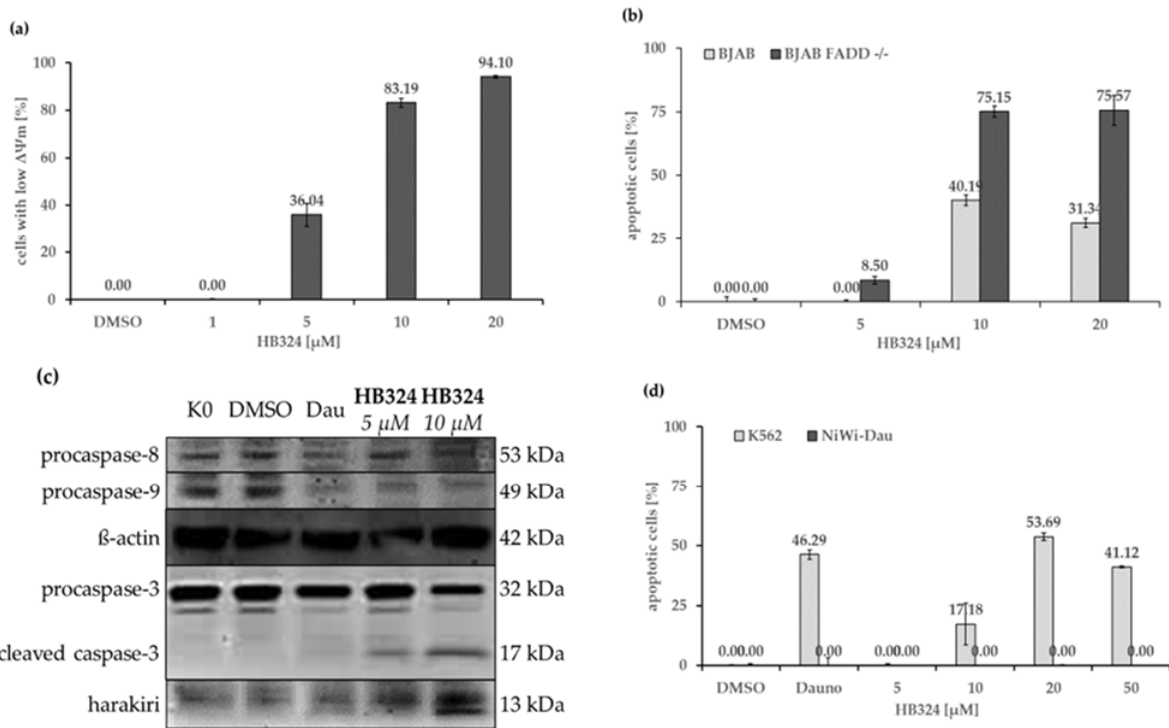
Figure 3. ( a ) Reduction of mitochondrial membrane potential measured by flow cytometric analysis of Nalm-6 cells after 48 h incubation with different concentration of HB324 and staining the cells with the cationic dye JC-1. Solvent treated cells (0.5% DMSO) served as the control. Values of the mitochondrial permeability transition are given as percentages of cells with low ∆Ψ m as mean values ± SD (n = 3). ( b ) BJAB and BJAB FADD − / − cells were treated for 72 h with three concentrations of the compound. Solvent treated cells (0.5% DMSO) served as the control. Nuclear DNA fragmentation was quantified by flow cytometric determination of hypodiploid DNA. Data are given in % hypoploidy (subG1), which reflects the number of apoptotic cells as mean values ± SD (n = 3). ( c ) Nalm-6 cells were incubated for 36 h with HB324 (5 µ M and 10 µ M) and 76 nM daunorbicin (Dau) as the positive control. Untreated and solvent treated cells (0.5% DMSO) served as the control. Proteins were separated by sodium dodecyl sulfate–polyacrylamide gel electrophoresis (SDS-PAGE) and subjected to Western blot analysis. Immunoblots developed with anticaspase-3, -8, -9 and antiharakiri is